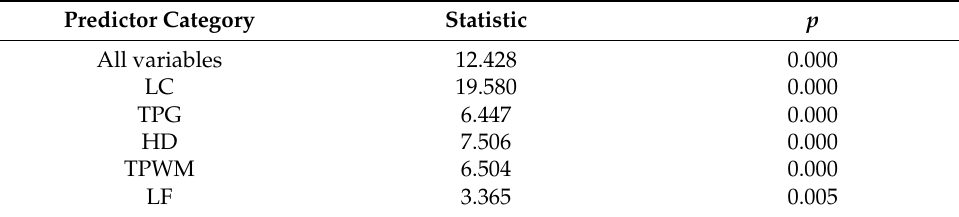
Table 4. Hotelling T 2 statistic. Significant differences are listed in bold.